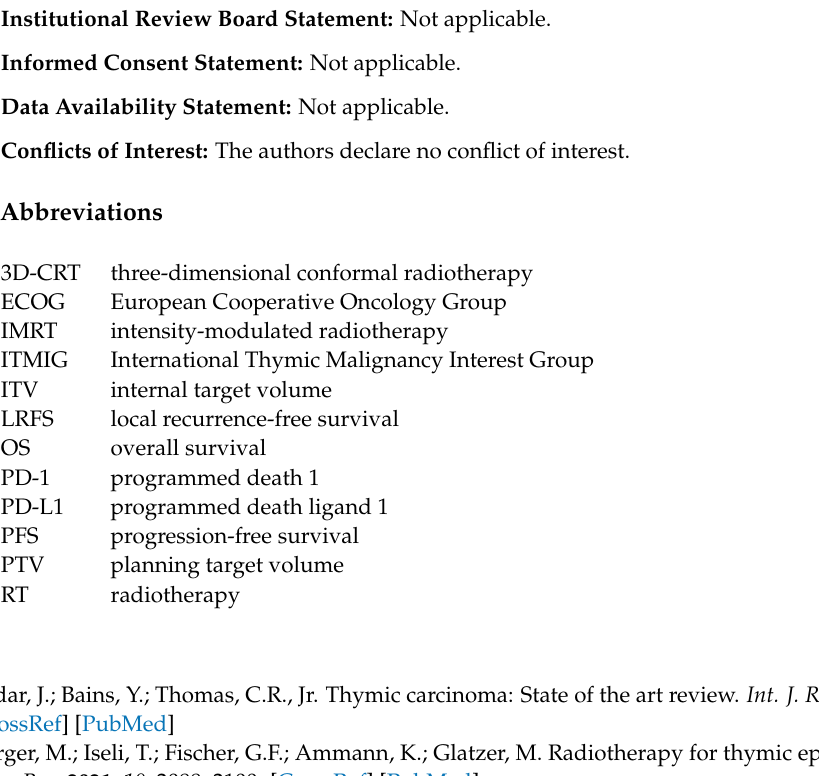
Table S2: Toxicity according to treatment